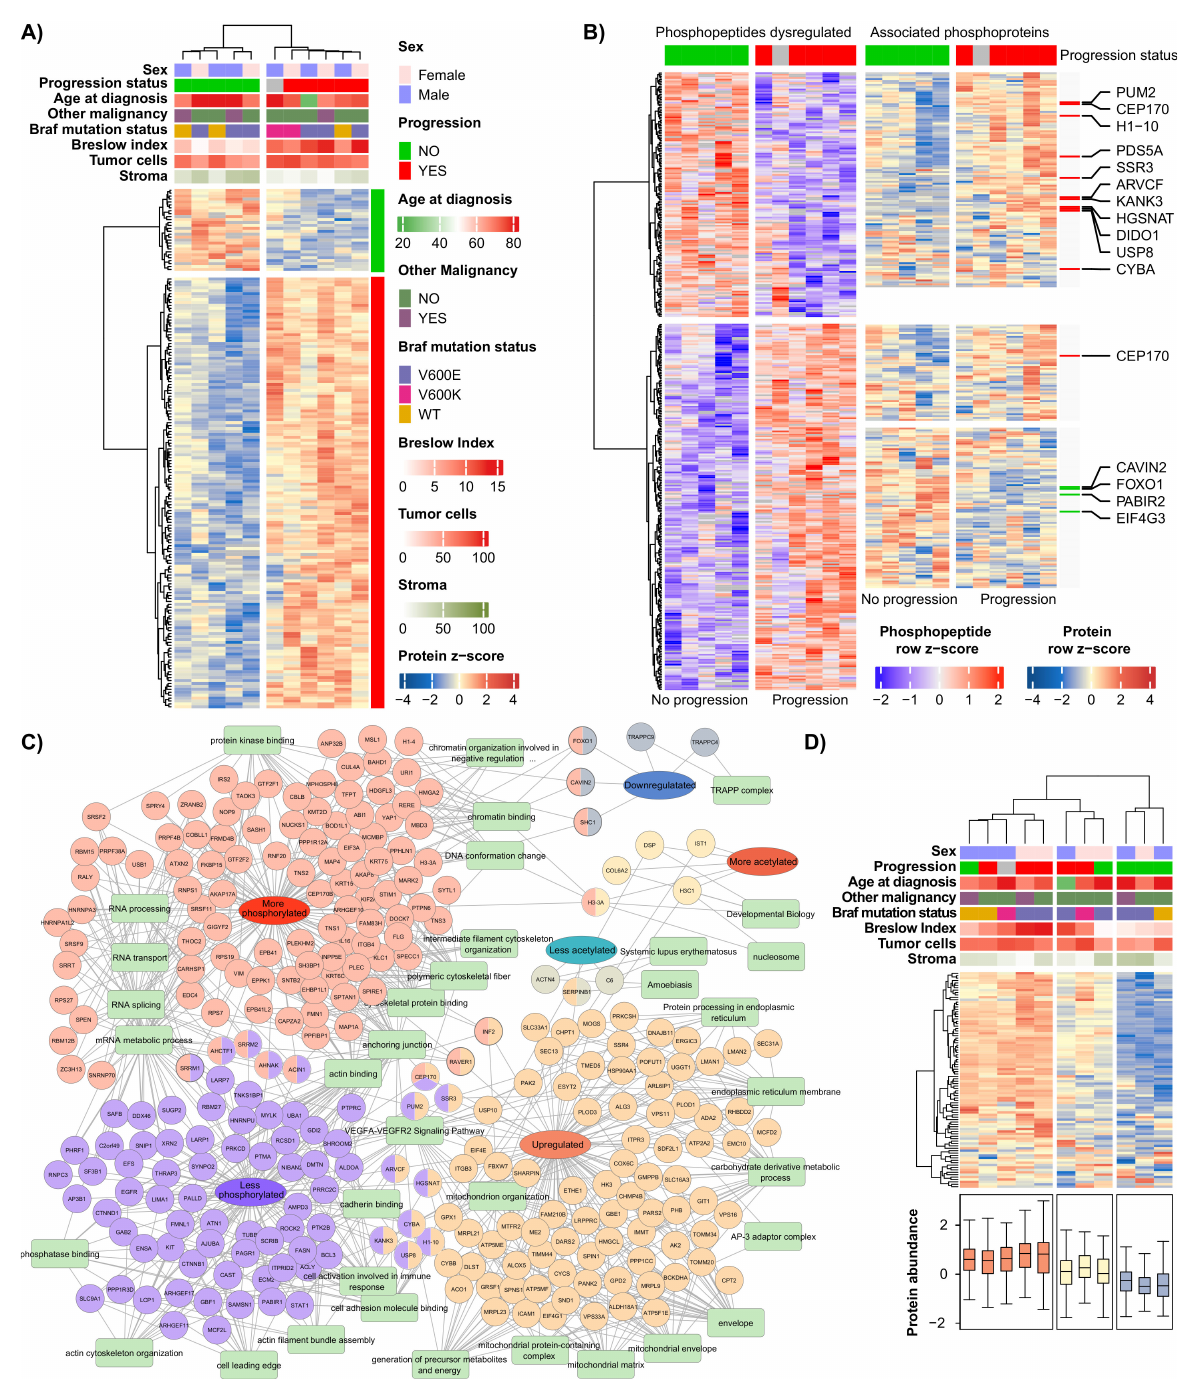
Figure 4. Molecular signature of the progression of primary melanomas toward metastatic disease. ( A ) Heatmap illustration of the significantly dysregulated proteins in primary melanomas from patient where the disease progressed. ( B ) Heatmap of the phosphorylated peptides dysregulated between the progression status groups, and their corresponding phosphoproteins. ( C ) Protein-biological annotation network of the clusters of proteins from differential abundance analysis of the proteins and PTMs dataset related to the progression of the disease. The analysis was performed using the ToppCluster function of the ToppGene Suite online version [20]. ( D ) Clustering analysis and heatmap illustration of the protein elements of the mitochondrial translation machinery. The corresponding abundance of the proteins in each sample is represented as a boxplot